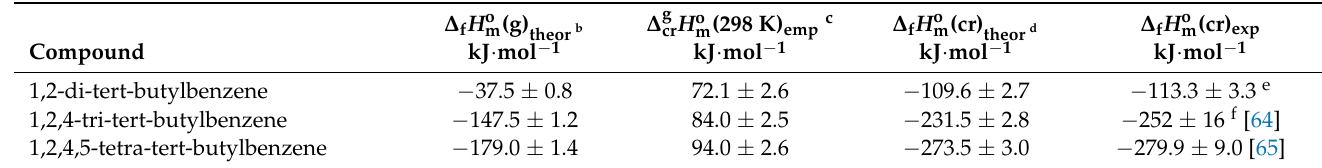
Table 11. Calculation of the crystal-phase enthalpies of formation of tert-butyl-benzenes at T = 298.15 K (in kJ.mol − 1 ) a